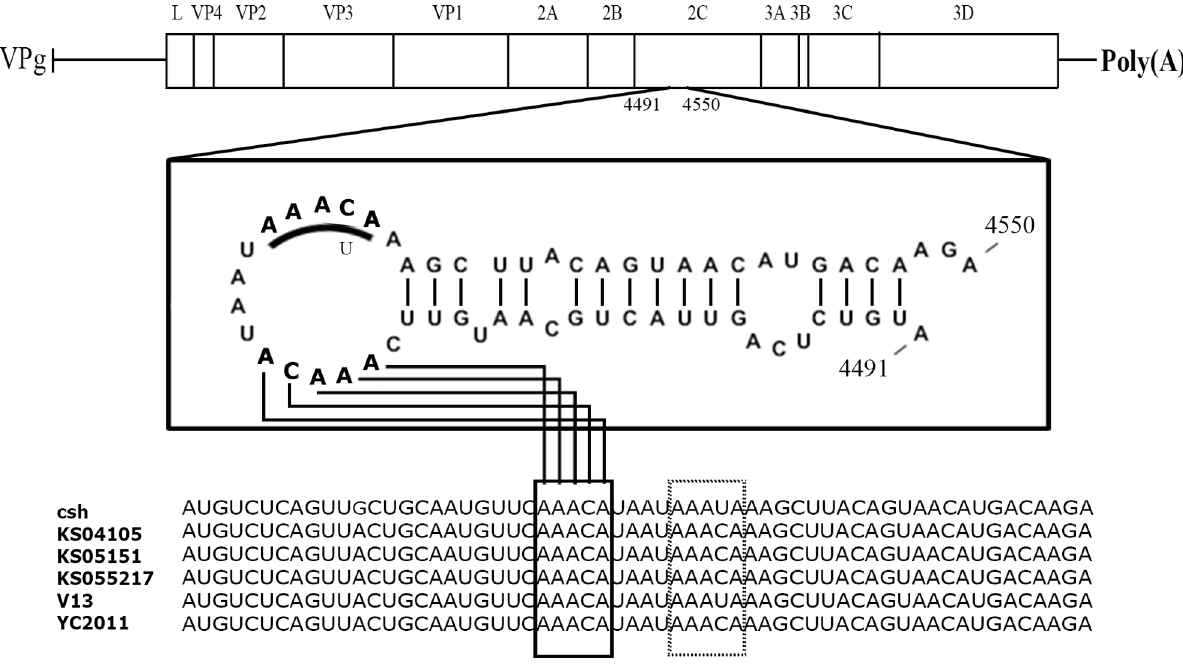
Figure 6. Sequences and structural feature of porcine sapelovirus cis -replication element ( CRE ). The first and second AAACA motifs are written in bold letter in the loop of the CRE .